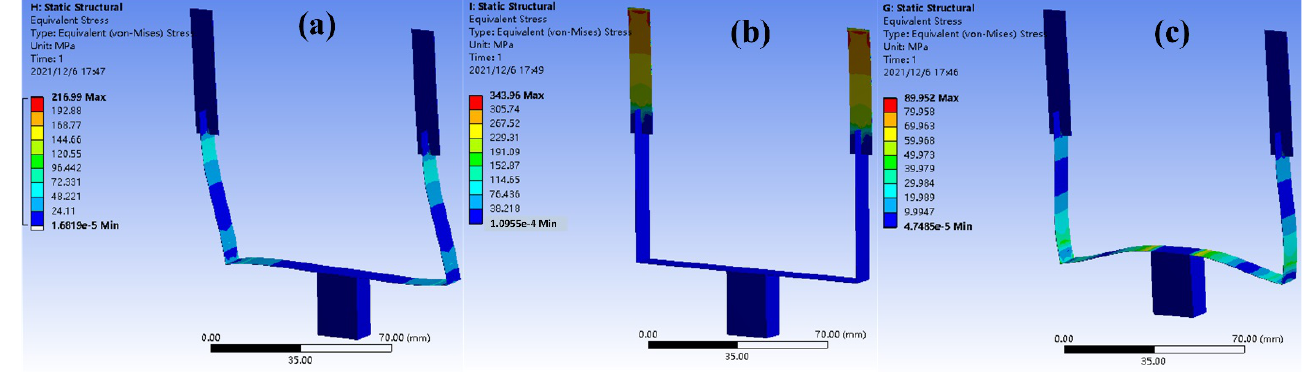
Figure 2. The stress distribution in the proposed U-shaped structure when stimulated by ( a ) x-axis, ( b ) y-axis, and ( c ) z-axis accelerations.